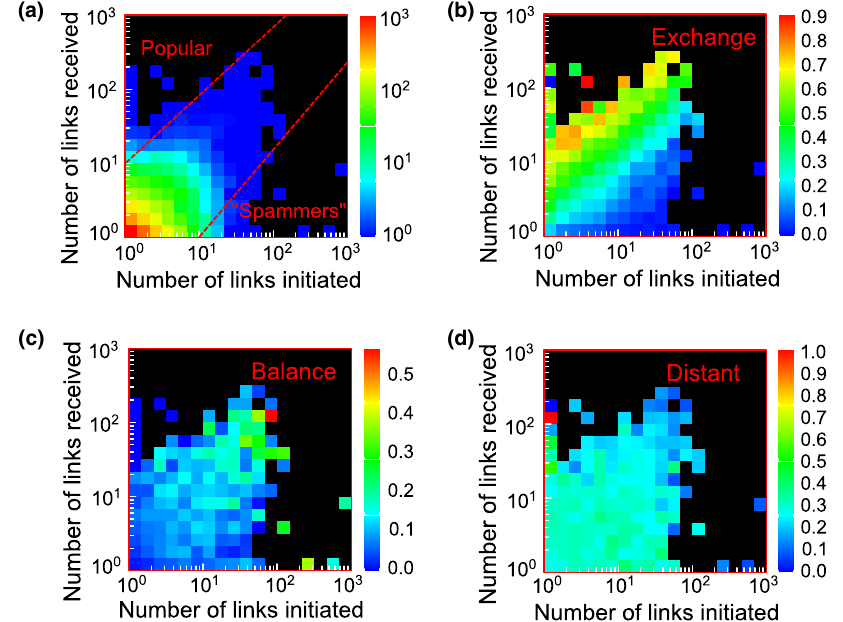
FIG. 6. (a) Histogram of the number of members as a function of the links that they initiated (x-axis) and the links that were pointed to them but initiated at the partner’s side (y-axis). (b–d) Average percentage of exchange, balance, and distant mechanisms as a function of the links initiated and